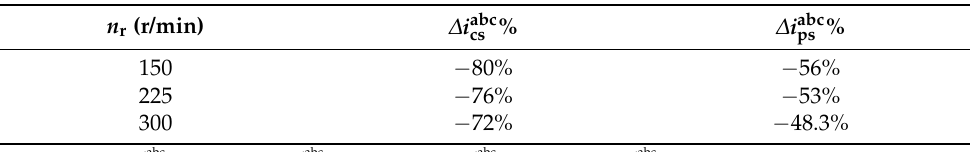
Table 2. Current comparison between the two control methods of MTPA-(SFV-FLC) and (SFV-FLC) when the speed changes.